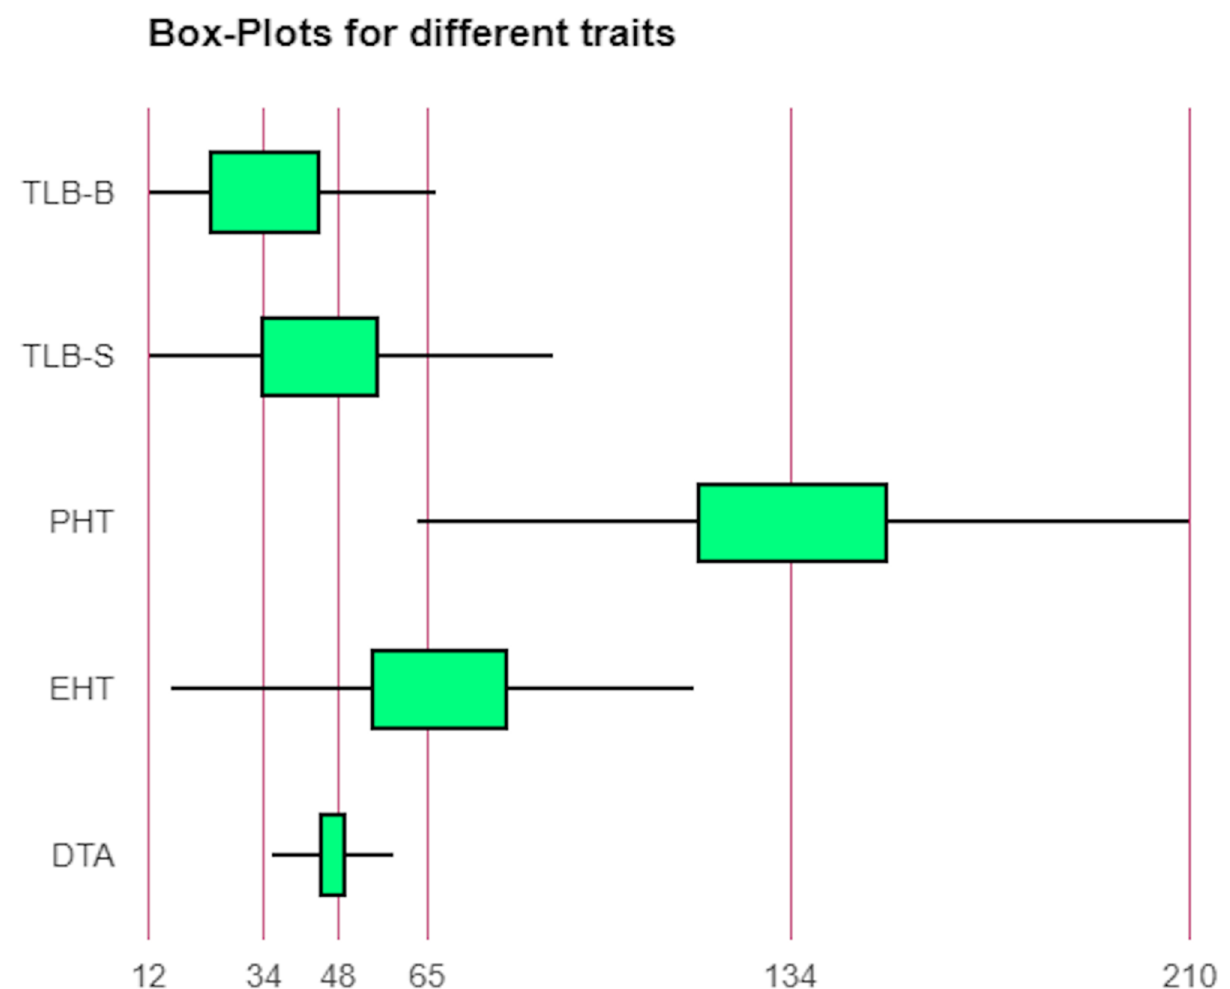
Figure 1. Phenotypic variability for days to anthesis (DTA), ear height placement (EHT), plant height (PHT), and turcicum leaf blight (TLB) at hots-spots location Srinagar (TLB-S) and Bajaura (TLB-B).